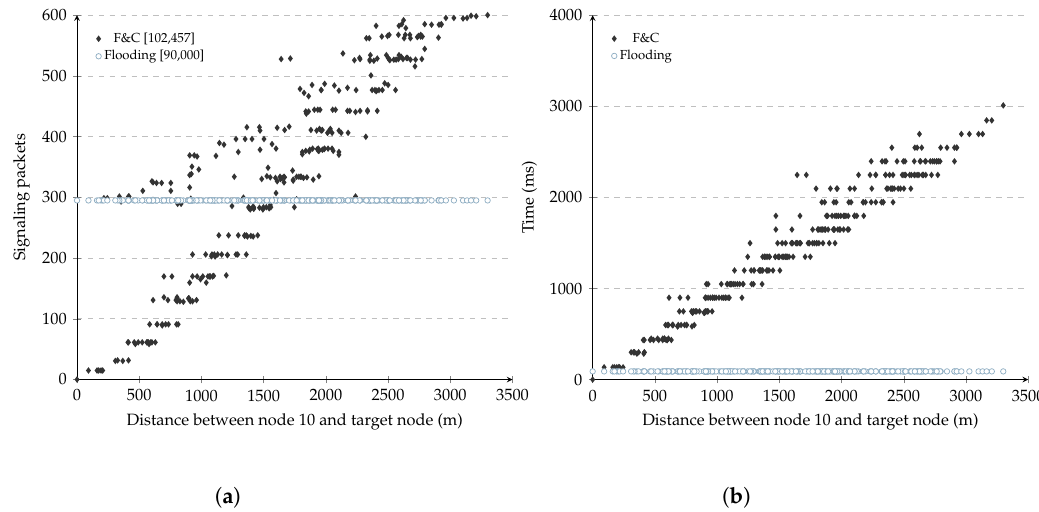
Figure 3. Signaling packets and route delay from node 10 to 299 nodes in the network. ( a ) Signaling packets; ( b ) Route delay. RQ: 150 ms, RP: 0